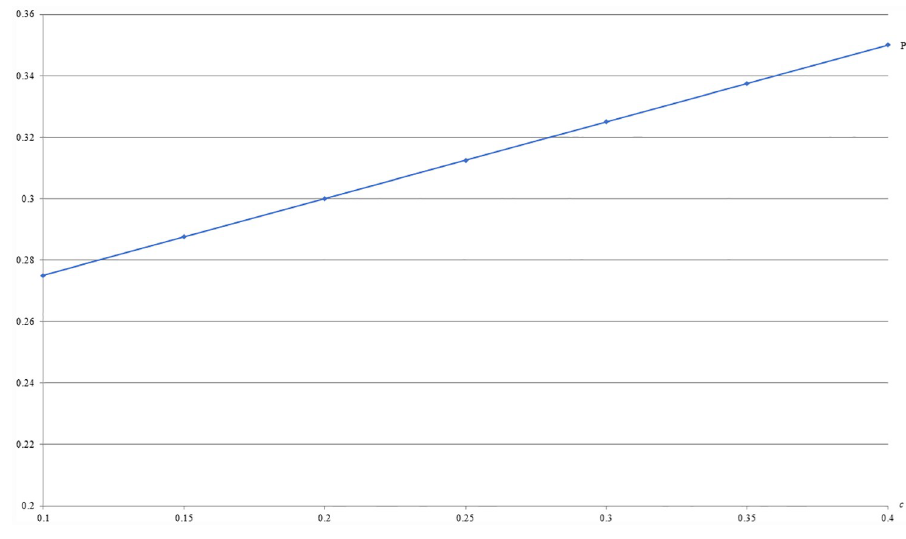
Fig 3. An illustration of the relation between price and c under